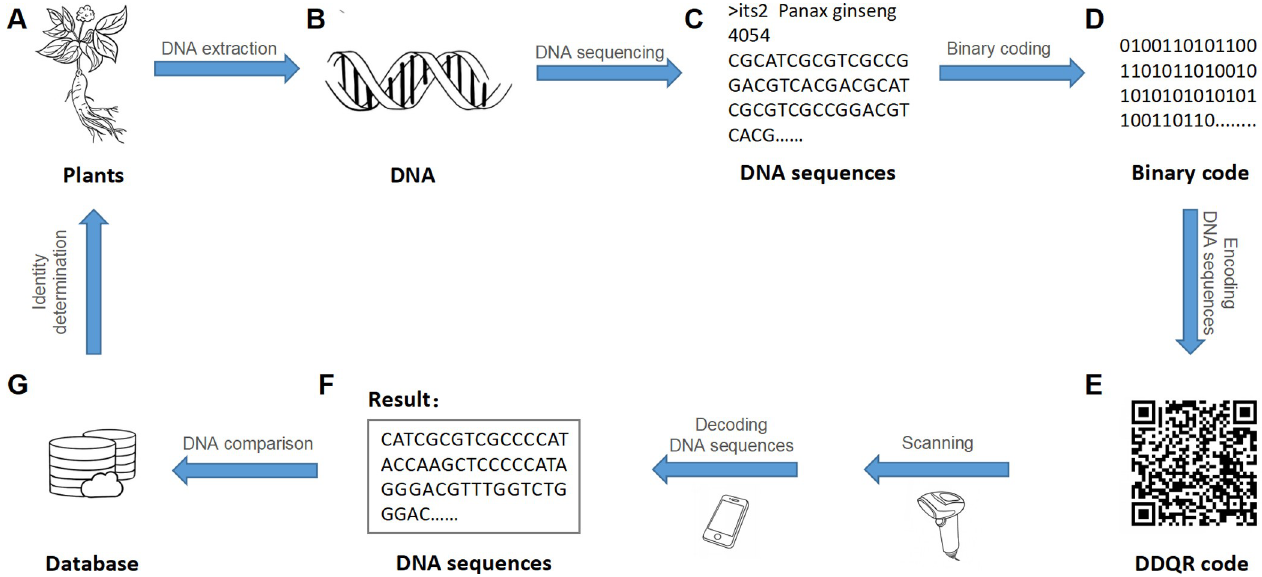
Fig 7. Exemplary application of DDQR in the storage and retrieval of DNA barcode sequence for plant material. We extract DNA from a plant sample (A), and the DNA sample (B) is subjected to Sanger sequencing, completing the sequence acquisition step. The resulting DNA sequence (C) is first converted to binary code (D). The binary code is then converted into DDQR code (E), completing the encoding step. Next, a scanner is used to scan the DDQR code, and then the DDQR code is decoded to the DNA barcode sequence (F). The sequence is compared with all sequences in the public database (G), allowing the identification of the plant